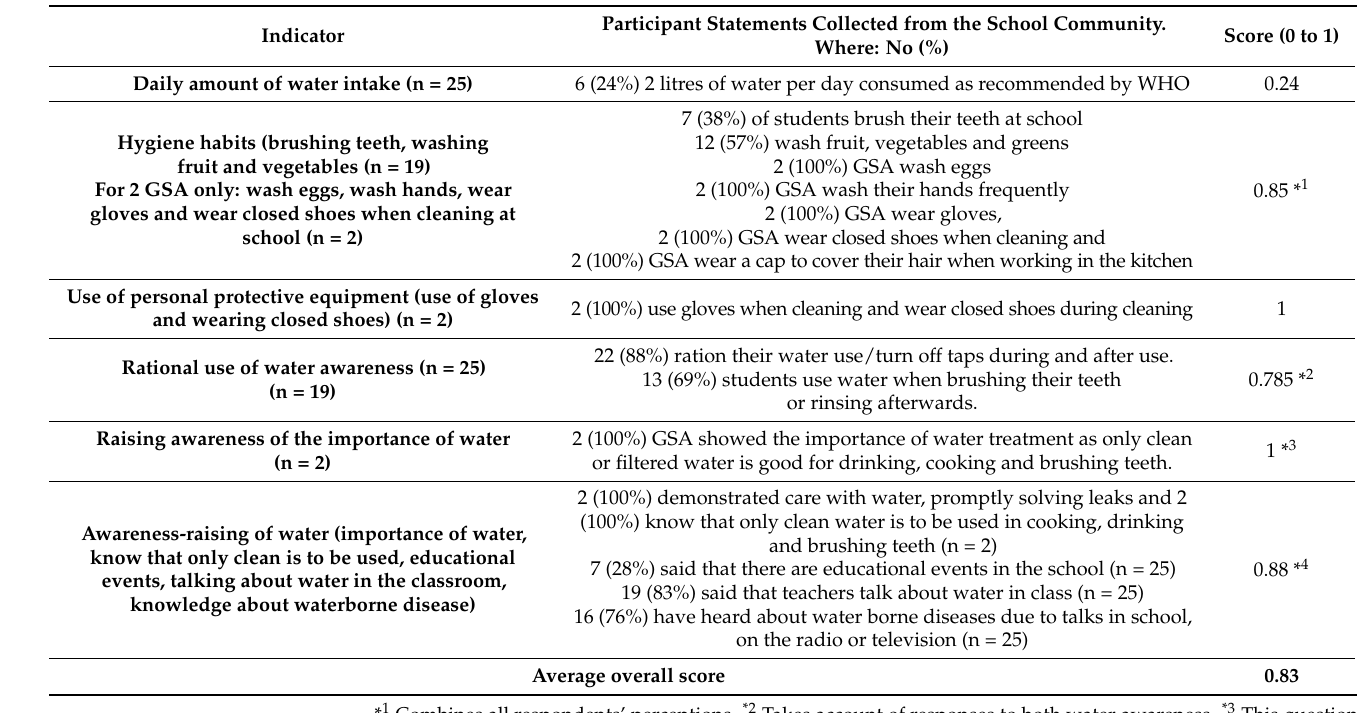
Table 9. Results of the survey carried out for the Sociocultural Dimension and its indicators. Weight- ing was 1; where n = total number of respondents.